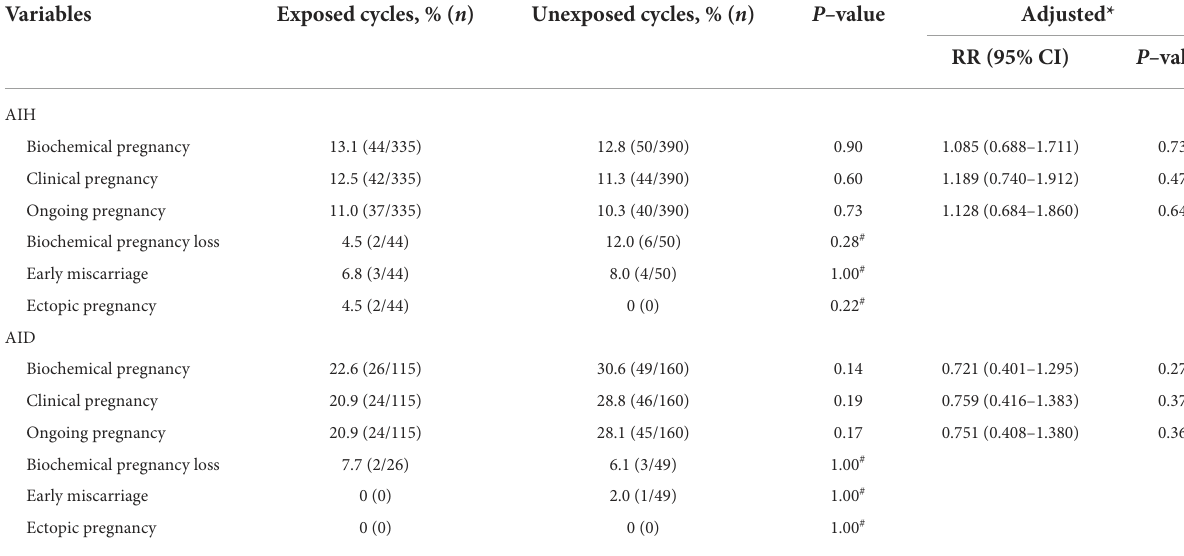
TABLE 4 Reproductive outcome of artificial insemination with husband or donor semen stratified by vaccine exposed or